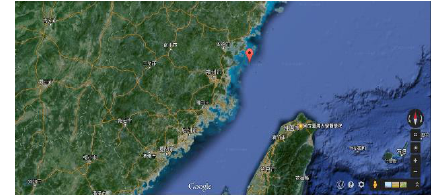
Figure 1. The location of Liangdao site(the red tag) (Source:Google Map,